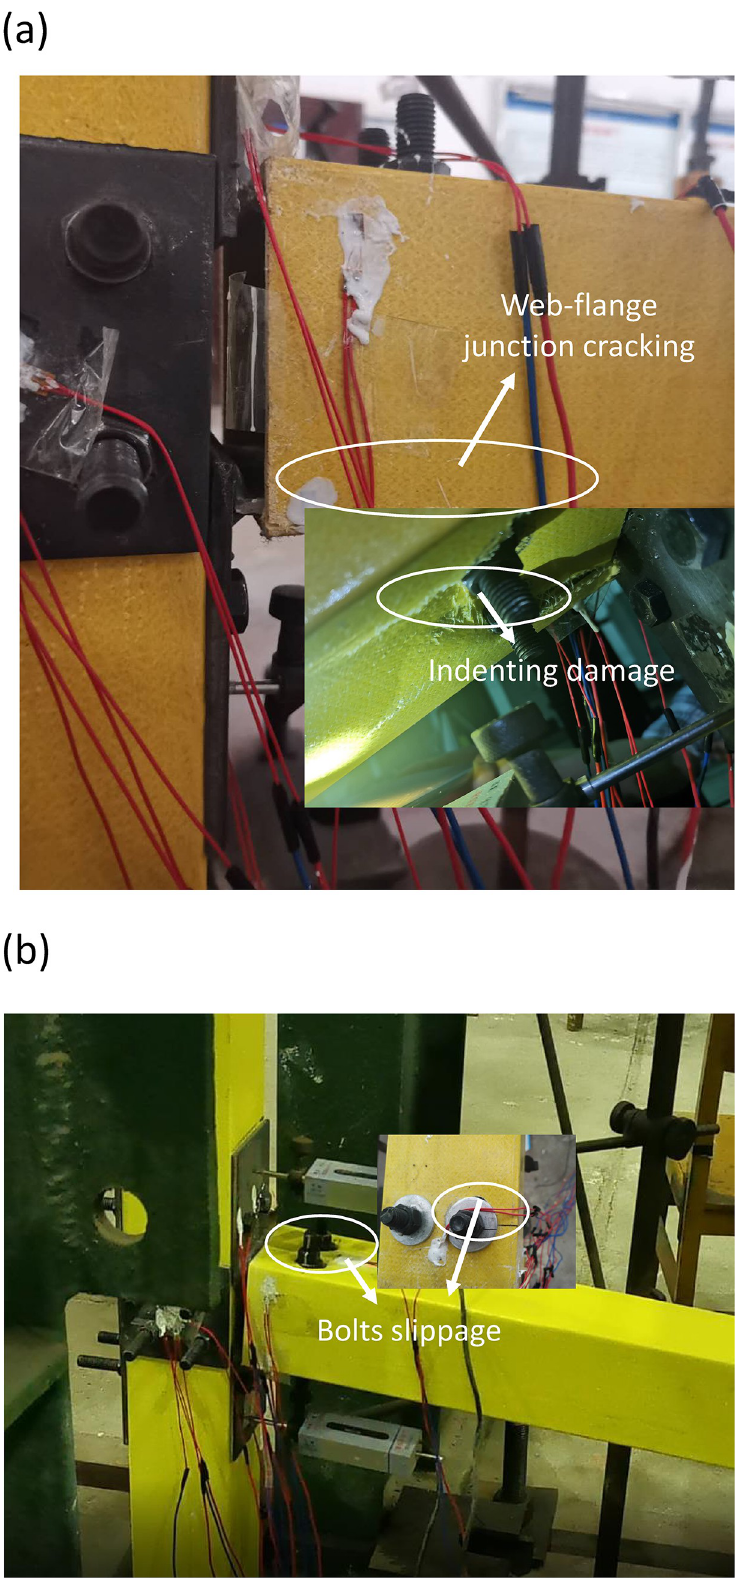
Fig 5. Failure modes of specimens of group J. (a) J1; (b) J2. https://doi.org/10.1371/journal.pone.0272136.g005 PLOS ONE | https://doi.org/10.1371/journal.pone.0272136 July 27,